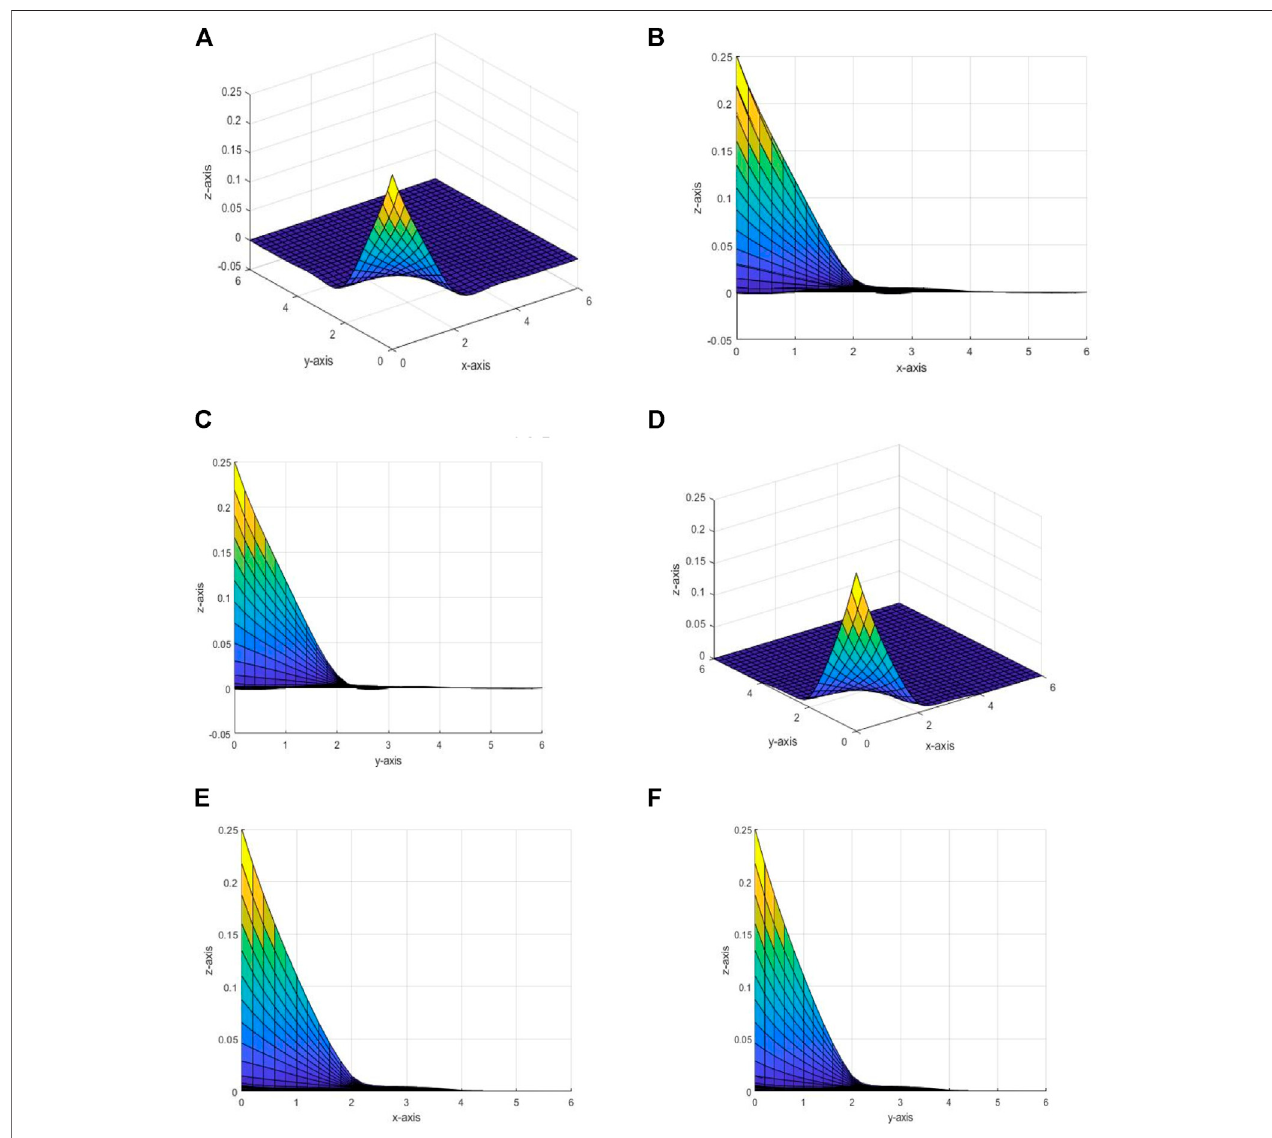
FIGURE 8 | Various interpolating surfaces. (A) Default surface. (B) xz-view for (A) . (C) yz-view for (A) . (D) Positivity-preserving surface. (E) xz-view for (D) . (F) yz- view for (D) . (G) Non-positivity-preserving surface. (H) Other view for (G) . (I) Positivity-preserving surface. (J) Other view for (I) .